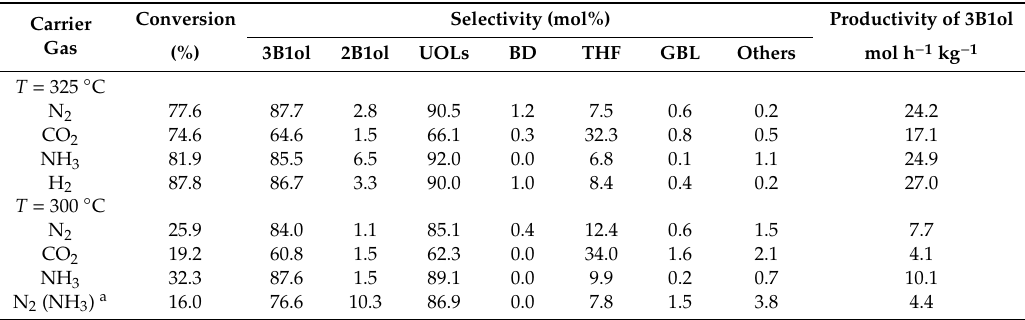
Table 7. E ff ects of carrier gas on the dehydration of 1,4-BDO over YZrO calcined at 900 ◦